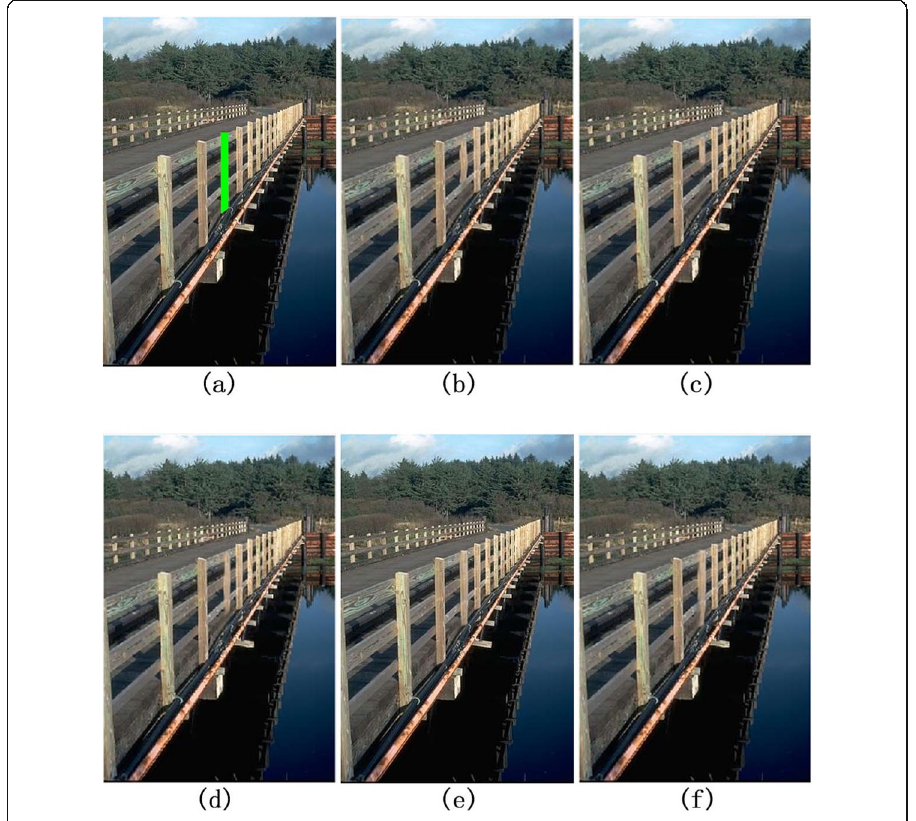
Fig. 10 Effect of patch size. a Input. b 5 × 5 patch size. c 7 × 7 patch size. d 9 × 9 patch size. e 11 × 11 patch size. f 13 × 13 patch